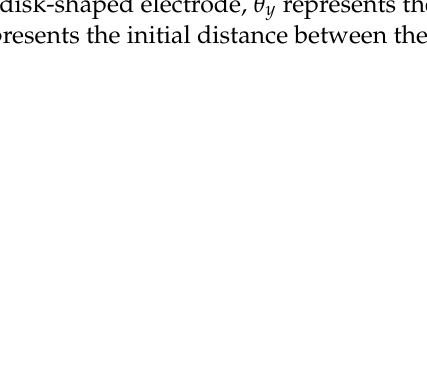
Figure 10. Schematic diagram of the semicircular sensing capacitance. The calculation principle of the sensitivity of the wheel structure is similar to Equa- tion (32), and the calculation results are as follows: